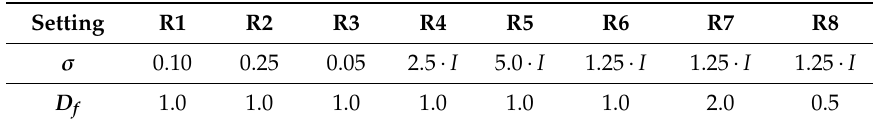
Table 1. Parameter settings used for the ODF model in the simulations in the simulations of backwards facing step